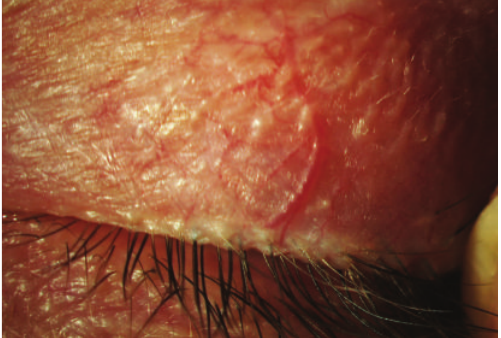
Figure 4: Moderate grade with a higher vessels